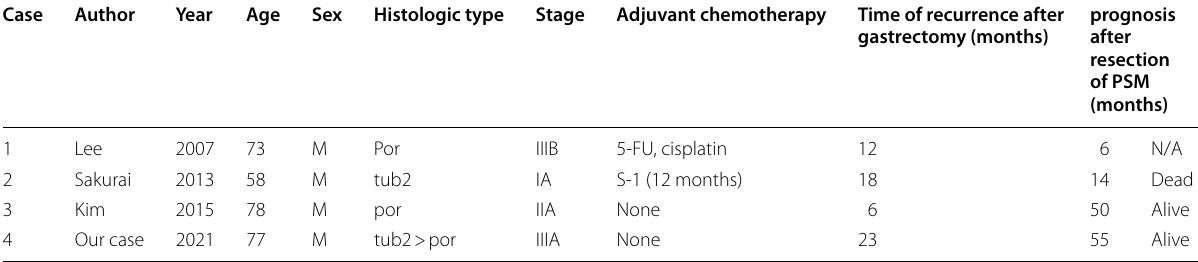
Table 1 Review of four reported cases of resected PSM from gastric cancer after curative gastrectomy